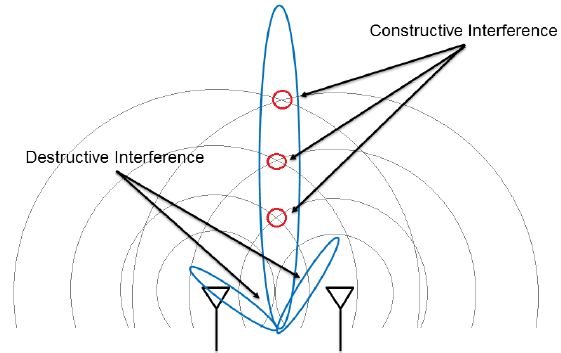
Figure 5. The beams caused by interference.